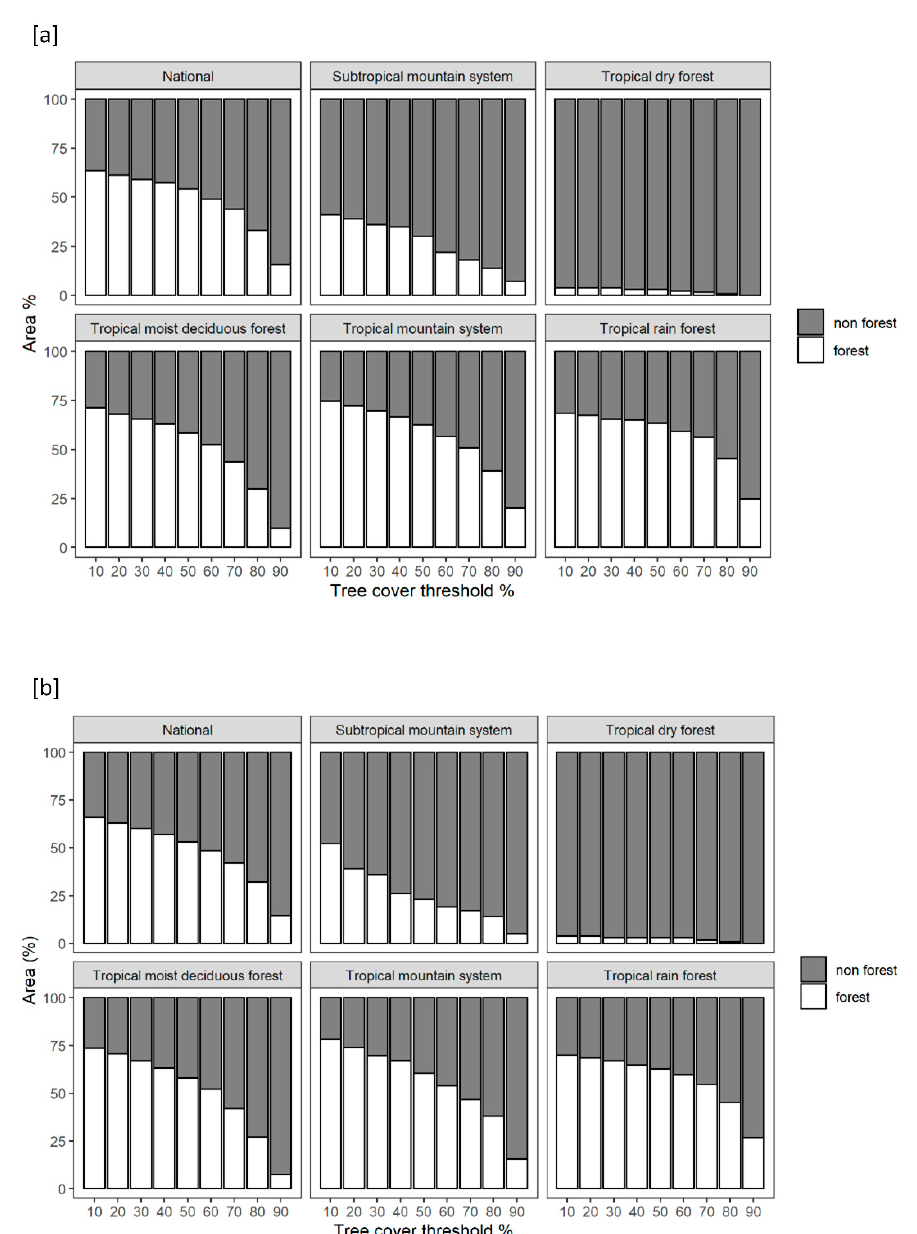
Figure 3. Percentage of forest and non ‐ forest in 2016 at the national scale and in the five ecological zones ( a ) using original percent tree cover and ( b ) using average tree cover percent of 3 × 3 neighboring